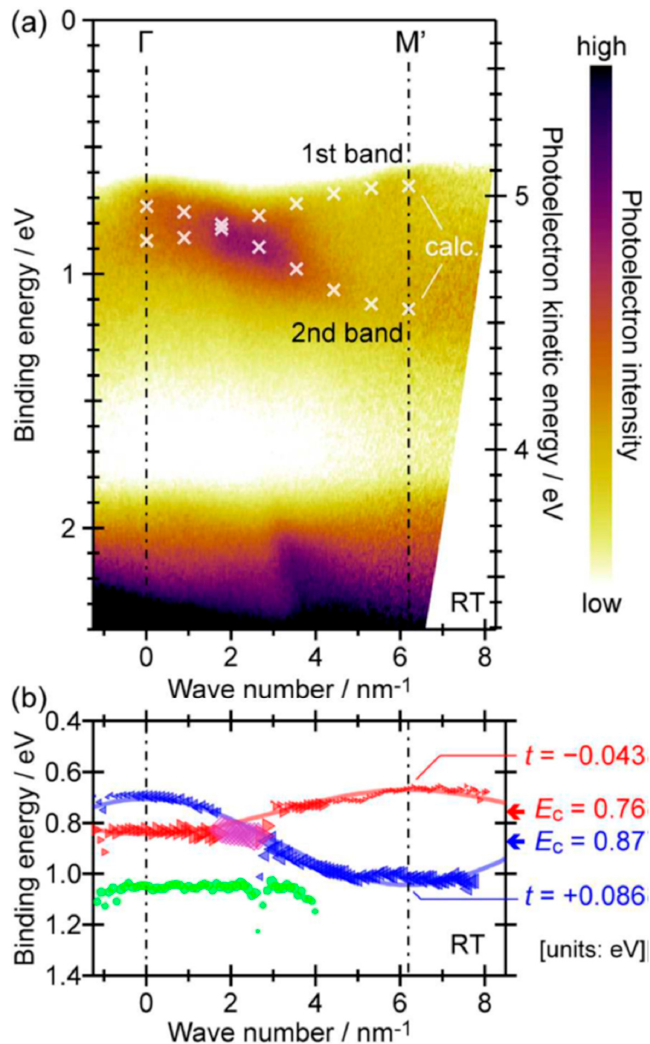
Figure 9. (a ) Pentacene Γ M ′ ARPES spectral image taken at RT mapped on the E − K ∥ plane. The band calculation results [88] are also plotted as cross marks. ( b ) Binding energy positions of the three